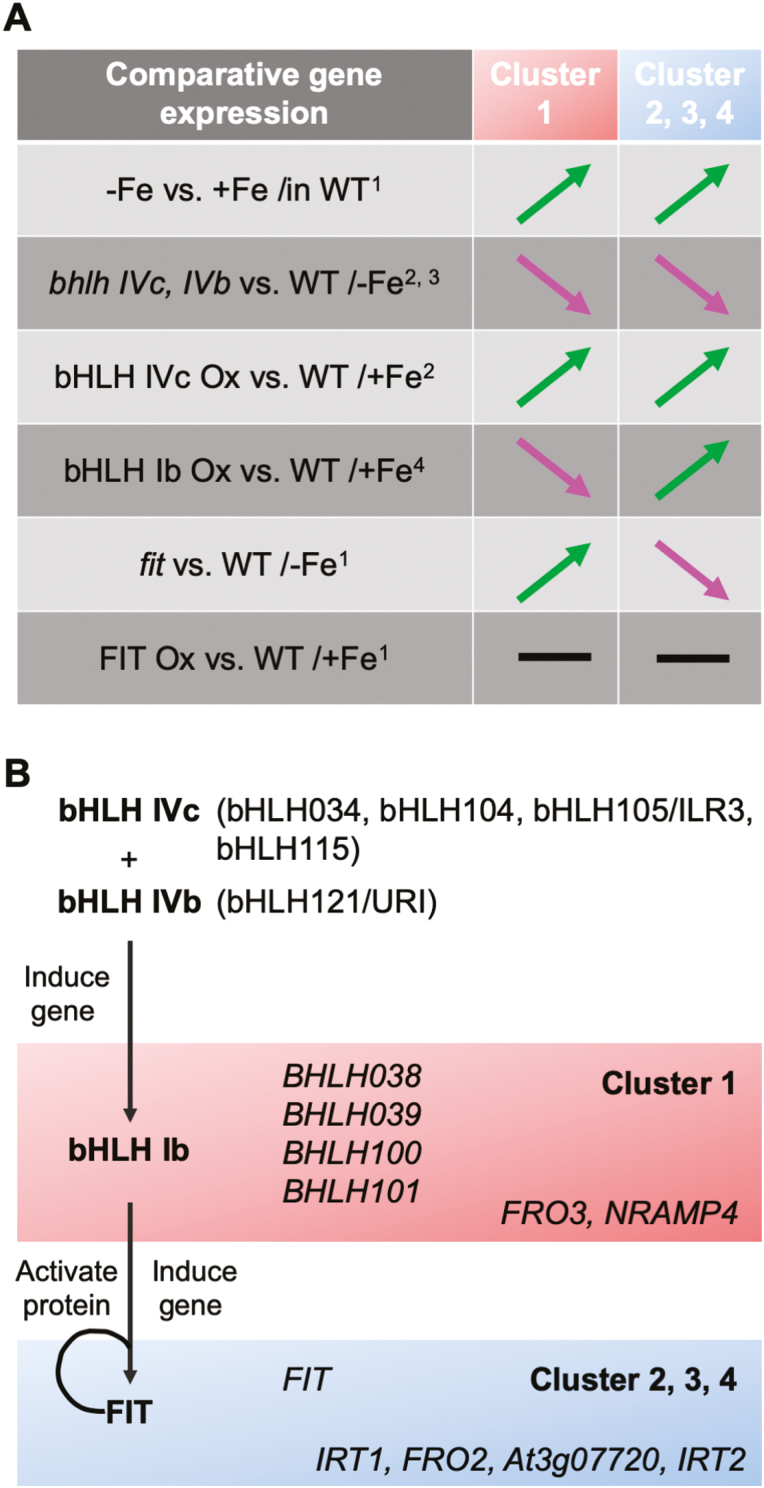
Use of co-expression clusters to integrate genetic components in a hierarchical model of Fe deficiency (–Fe) response regulation. (A) Summary of FIT-independent cluster 1 and FIT-dependent cluster 2, 3, and 4 gene regulation in the respective comparative analyses: 1(Mai et al., 2016), 2(Zhang et al., 2015; Li et al., 2016; Tissot et al., 2019), 3(Gao et al., 2019a; Kim et al., 2019), and 4(Naranjo-Arcos et al., 2017); green and pink arrows, up- and down-regulated in the comparison; black trait, not regulated. (B) bHLH transcription factor cascade regulating cluster 1–4 genes in response to –Fe. bHLH subgroup IVc proteins and bHLH121/URI bHLH IVb protein bind to the promoters of BHLH subgroup Ib genes and other cluster 1 genes. bHLH subgroup Ib proteins interact with and activate FIT to steer induction of cluster 2, 3, and 4 genes. A feedback from Fe signals to bHLH factors is not indicated in the scheme. Characteristic example marker genes are noted. Further information on cluster 1–4 genes is provided in the text, Fig. 1, and Supplementary Table S1.